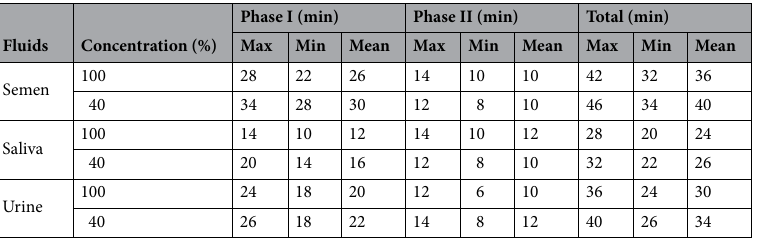
Table 2. Summarized the minimum, maximum and mean values of two phases of body fluid drying.